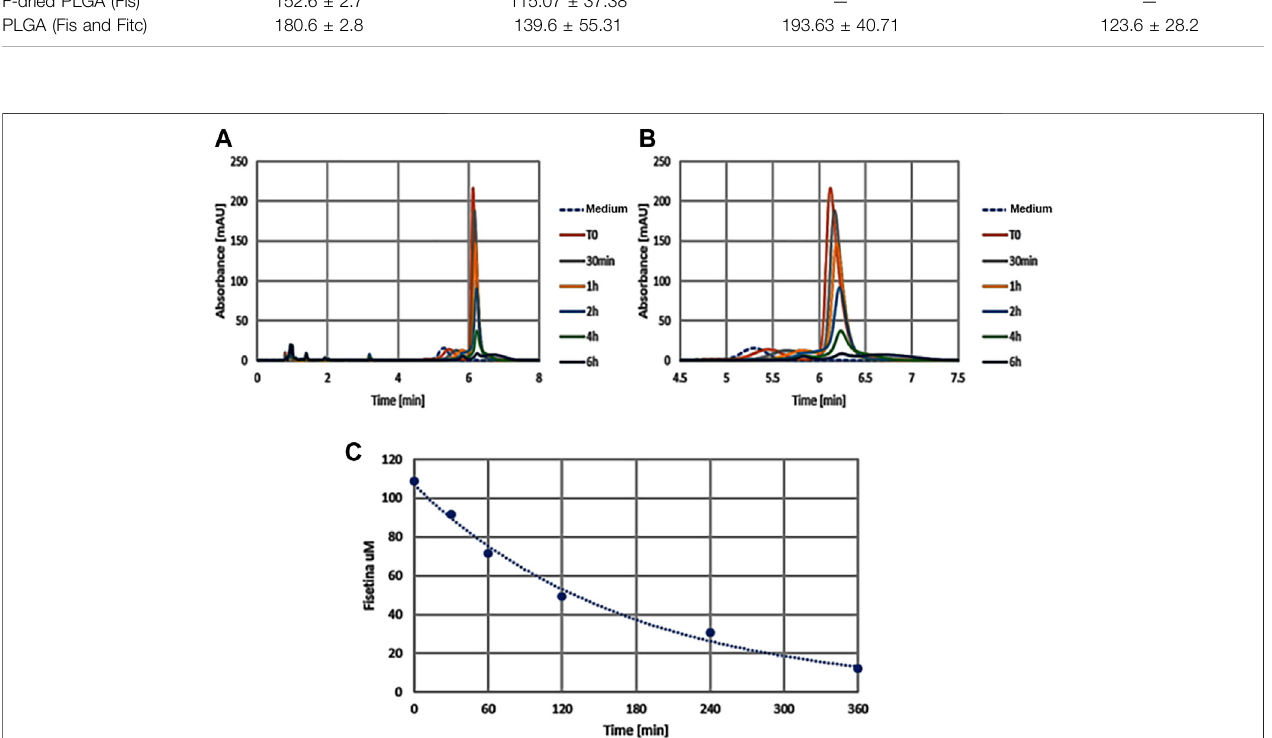
FIGURE7| Thegraphicsshowabsorptionpeaksof fi setinat360nminculturemediumatdifferenttimes(inxaxis):withthepassageoftimethemoleculedegrades andthepeakislowered,untilitdisappearslater6h.Theimageontheleft (A) showstheentiredurationoftherun(from0to8htimelapseinculturemedium),whiletheone ontheright (B) onlyaroundtheretentiontime(from4.5to7h).Ascontrolweusedthecolturemedium(Medium)without fi setinsupplementation.Thedegradationkinetics of fi setin is shown in graphic C .